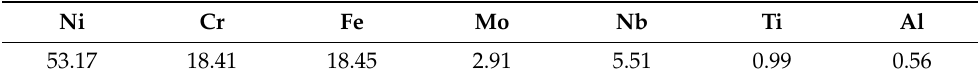
Table 1. Chemical composition of Inconel 718 (% wt)